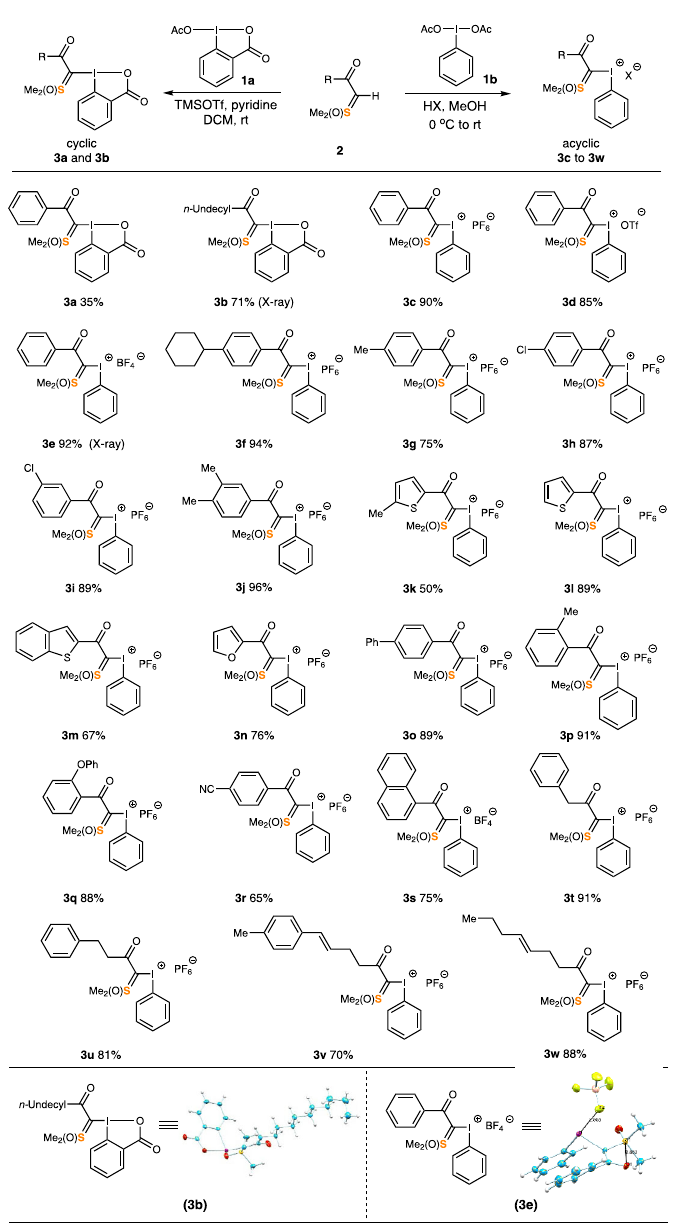
Fig. 2 | Synthesis,scope,and X-raystructures ofI (III) /S (VI) reagents. X-raycrystal structures of reagents 3b and 3e. The thermal ellipsoids are drawn at 50% prob- ability. 3b : selected torsion: C23-C22-I1-C1= − 5.77(2)°; C22-I1-C1-C2=92.69(2)°. Select bond lengths: I-C1=2.059(3) Å, I-C22=2.130(2) Å, C1-S1=1.715(3) Å, C1- C2=1.431(3) Å, O2-C2=1.230(4) Å. Selected bond angles: C1-I-C22=97.35(1)°, C22-